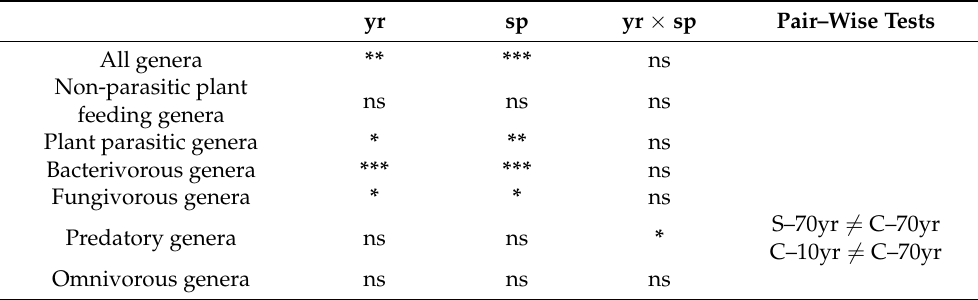
Table 3. PERMANOVA results for the effects of factors “year”, “species” and their interaction on multiple variable data sets, i.e., abundances of nematode genera (ns: non-significant; *: p < 0.05, **: p < 0.01, ***: p < 0.001). In the case of significant interaction effect, the significant differences revealed by pair-wise tests are indicated.